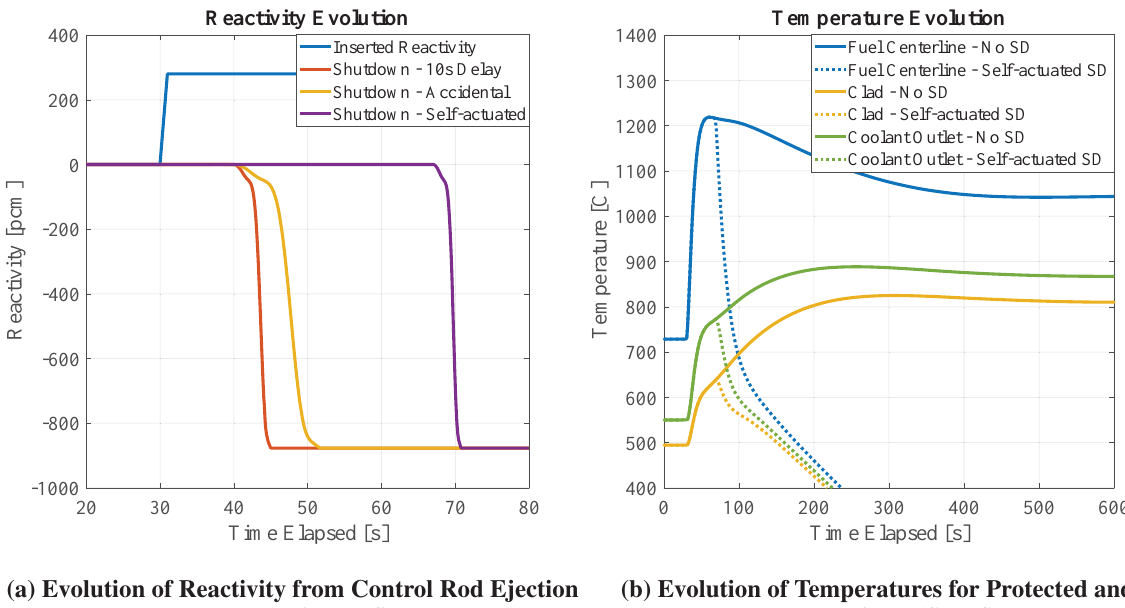
Figure 5: Reactivity and Temperature Evolution Following 0.5$ Reactivity